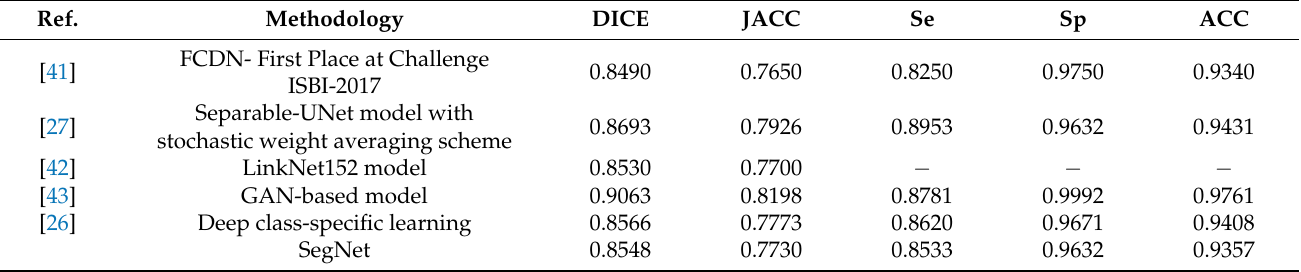
Table 2. Segmentation results of benchmark methods over the Test set (600 images). The results obtained with the SegNet neural network have also been included to facilitate the